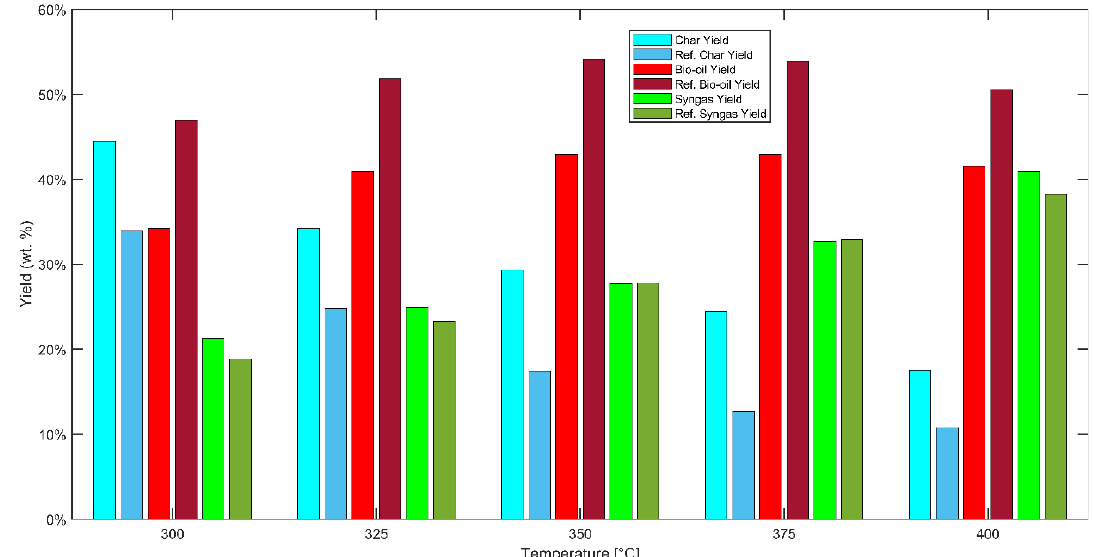
Figure 2. Validation of pyrolysis product yields — comparison with [34].